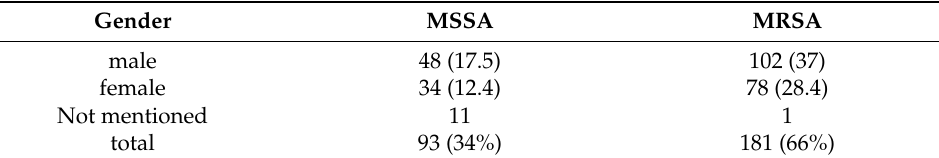
Figure 3. Gender differences in methicillin-resistant and susceptible Staphylococcus aureus distribu- tions among men and women in the Ha’il region, Saudi Arabia. Table 3. Gender-specific distributions of Staphylococcus aureus lineage infections in Ha’il region, Saudi Arabia.